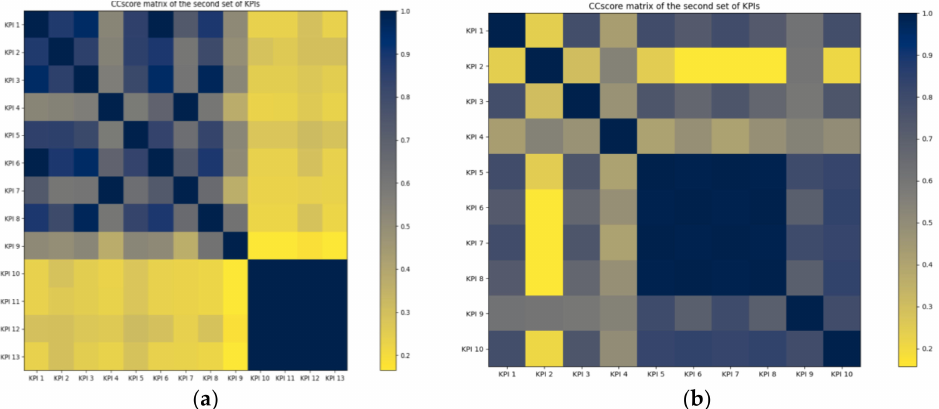
Figure 8. Heat map of KPI correlation matrix: ( a ) correlation matrix for the first set of KPIs; ( b ) corre- lation matrix for the second set of